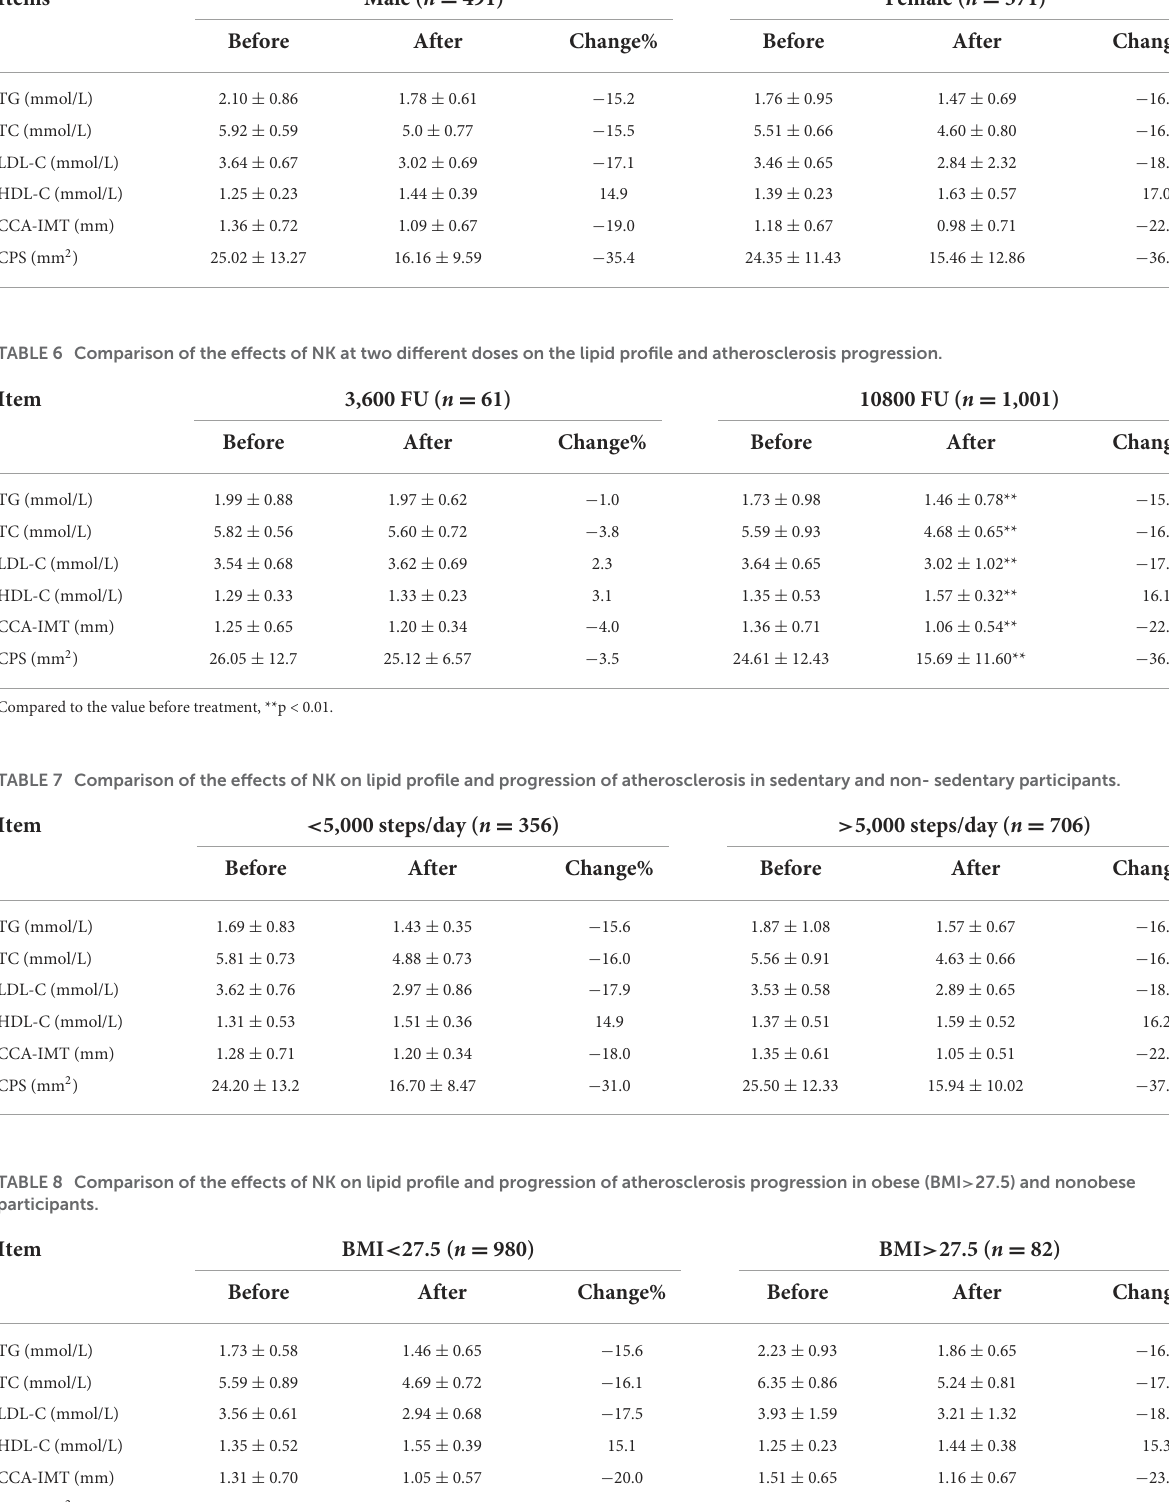
TABLE 5 Comparison of the effects of NK on lipid profile and atherosclerosis progression in male and female participants. Items Male ( n = 491) Female ( n = 571) Before After Change% Before After Change%